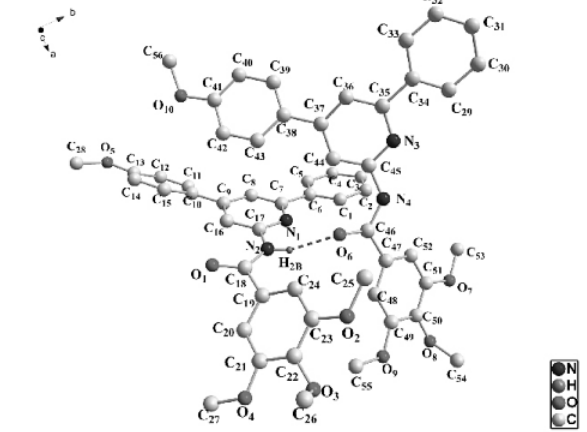
the title compound were dissolved in a mixture of PE/EA (1:3, v / v ), and the solution was kept at room temperature for five days. for X-ray diffraction analysis.